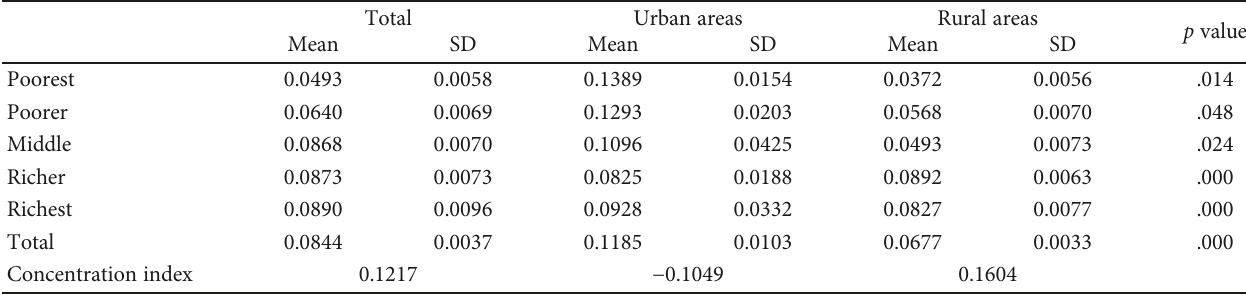
Table 2: Prevalence of self-reported diabetes and concentration index among middle-aged and elderly adults. Total